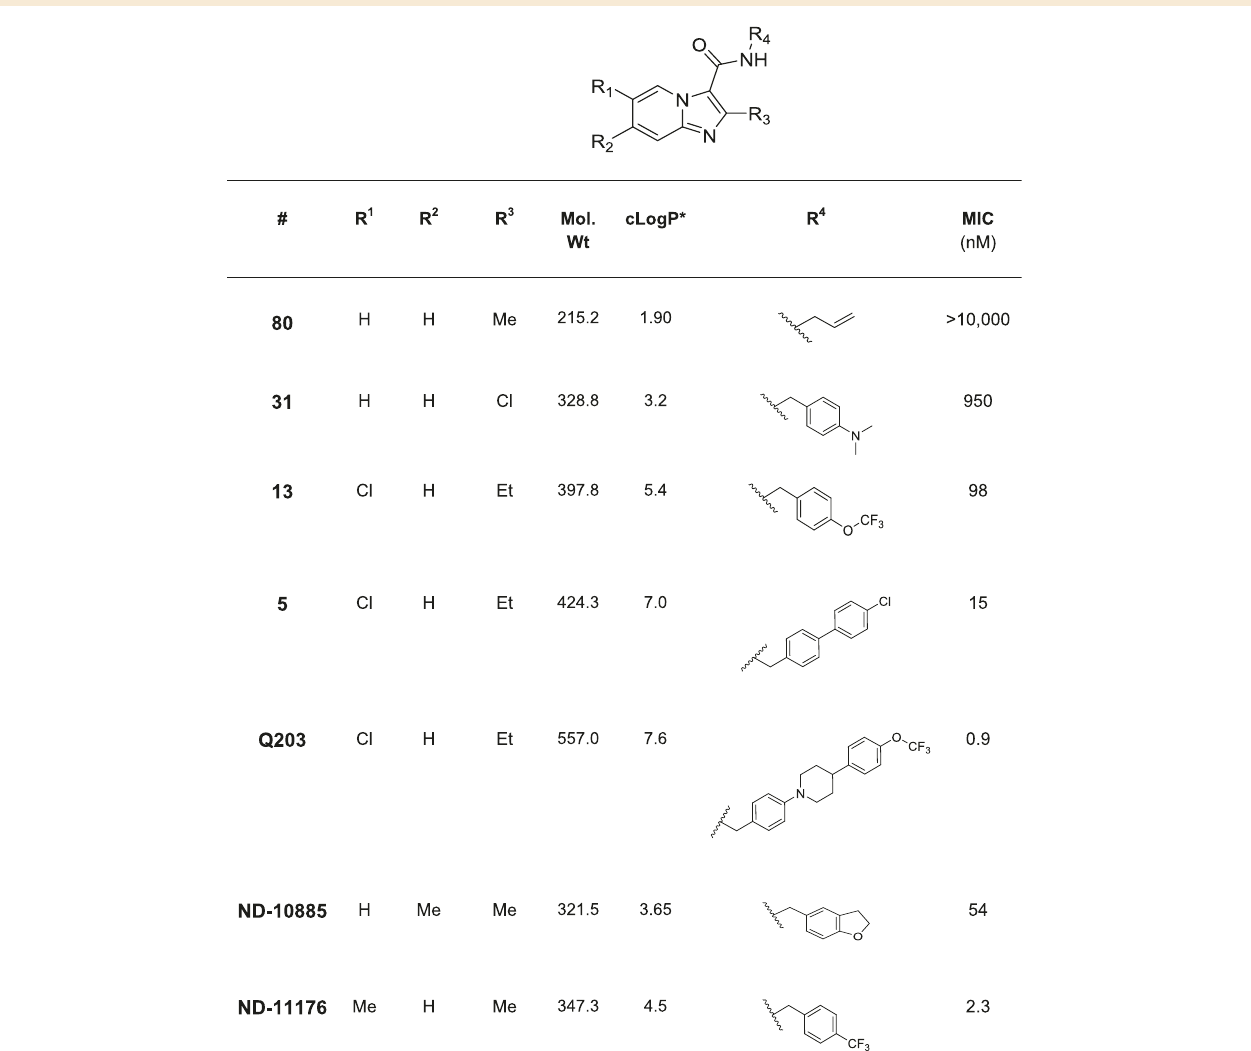
Table 1 Activity of IPA derivatives against the classical M. ulcerans strain